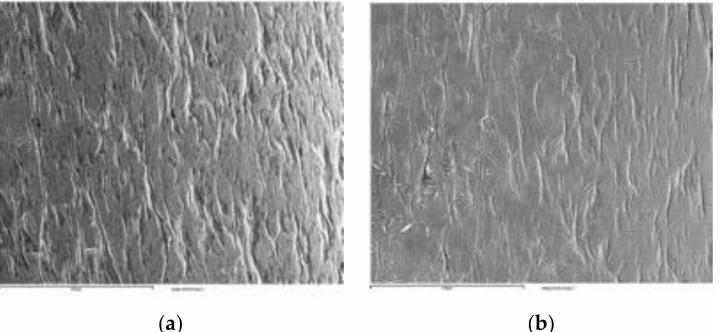
Figure 16. Images of hypotube #1: ( a ) before the intergranular test (scale = 100 µ m) and ( b ) after the intergranular test (scale = 100 µ m).